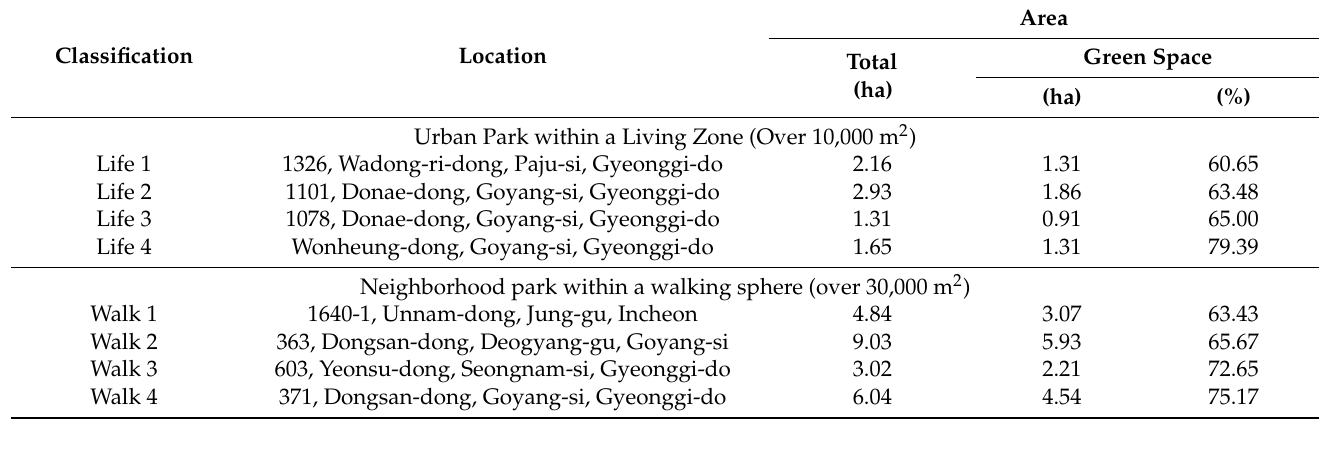
Table 1. Selection of study sites for evaluating the water balance of urban parks.